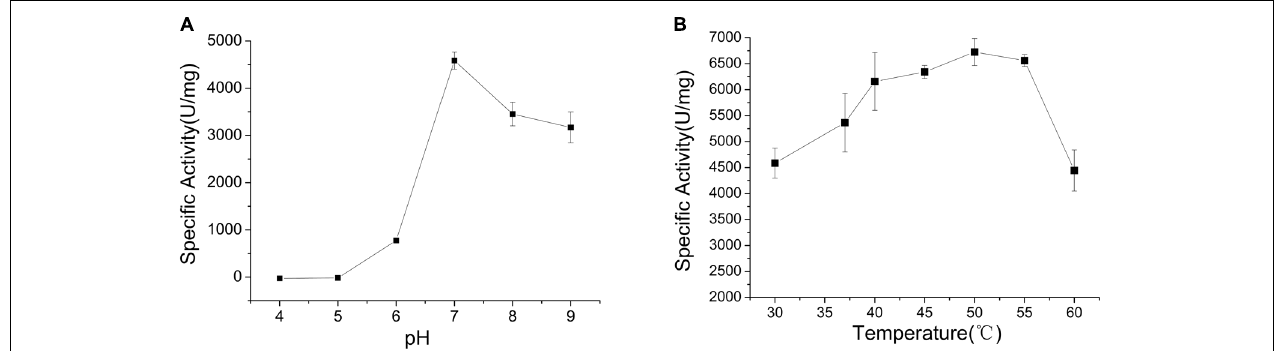
FIGURE 3 | Effects of pH and temperature on the activity of CHAO YT − 02 . (A) Effect of pH on CHAO YT − 02 activity at 30 ◦ C. (B) Effect of temperature on CHAO YT − 02 activity.